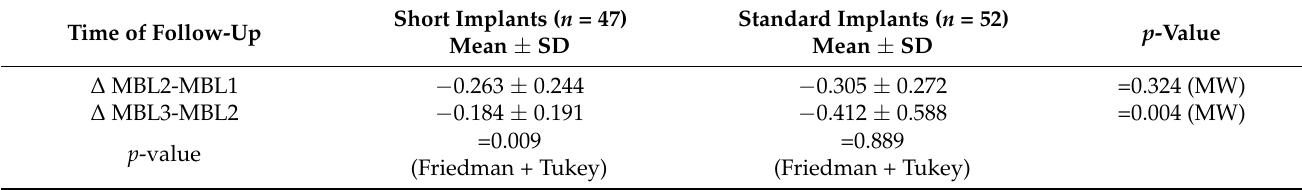
Table 3. Comparison of the increases of the vertical distance from the implant shoulder to the most coronal aspects of implant–bone contact (MBL) (medial, mesial, and distal) between both study groups at the two follow-up time points.